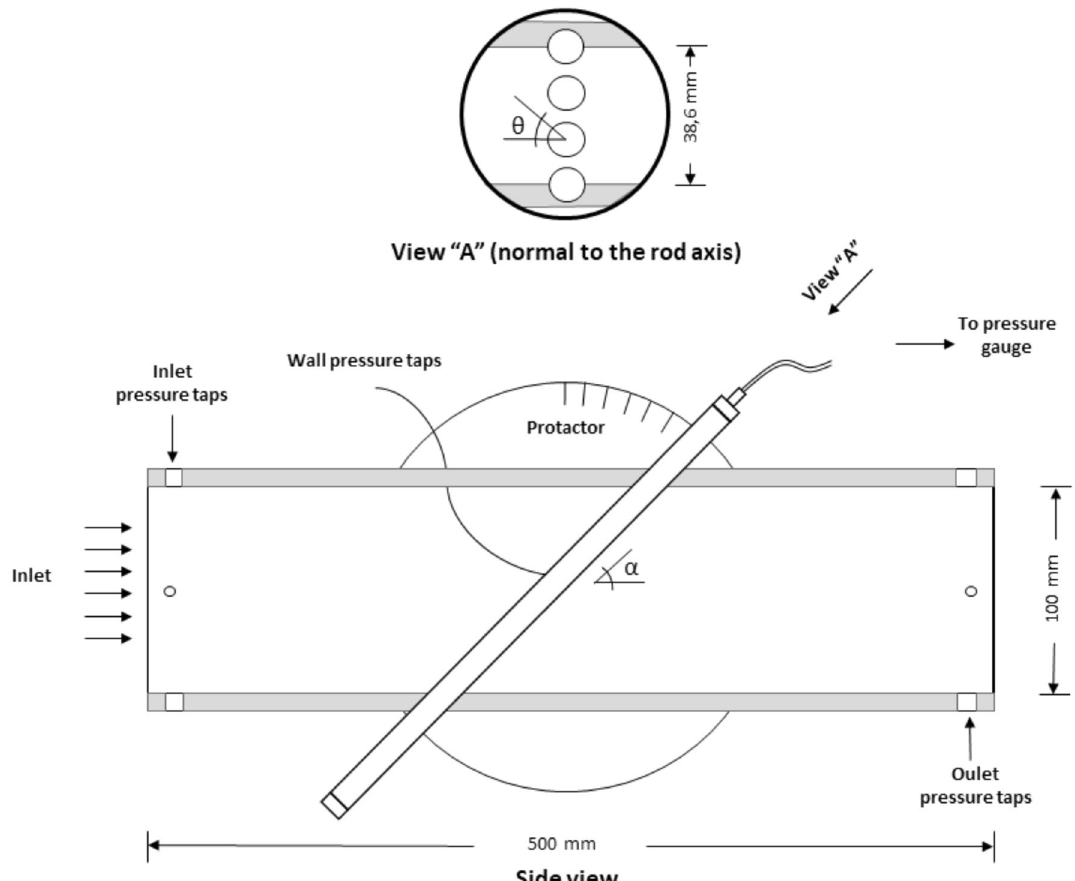
Figure 3. Flow setup. The channel walls are shown in grey. The flow goes from left to right and is obstructed by the rods. Note that the view “A” is normal to the rods axis. The external rods are semi-embedded in the lateral channel walls. The protractor is used to measure inclination angle α . Created with Openscad 2021.01,